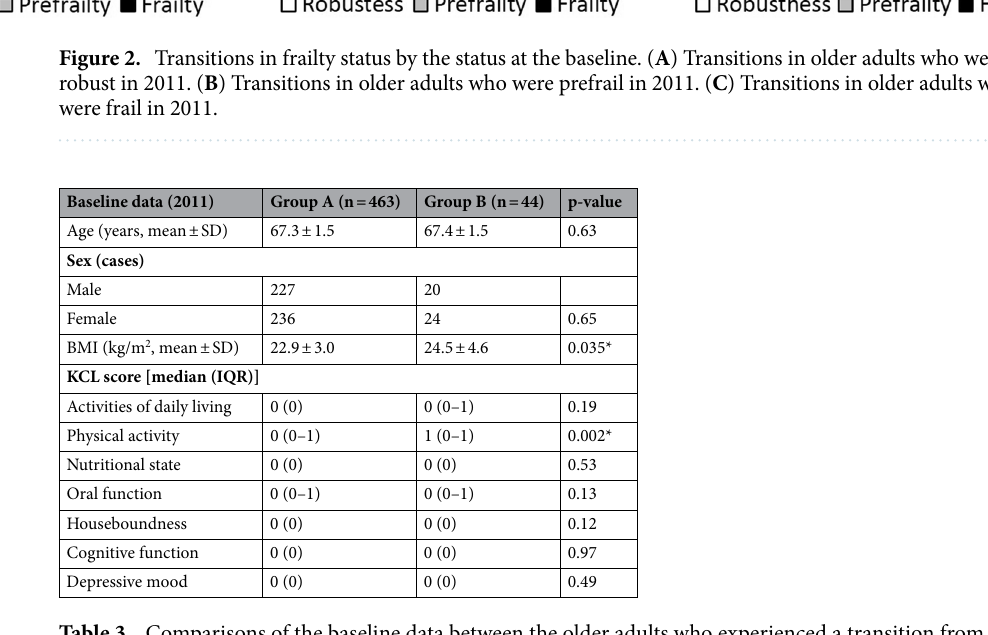
Table 3. Comparisons of the baseline data between the older adults who experienced a transition from non- frailty to frailty and those who did not. Group A included older adults who were non-frail both in 2011 and 2016 and group B included those who had transitions from non-frailty to frailty. BMI body mass index, SD standard deviation, KCL Kihon Checklist, IQR interquartile range. *p < 0.05.